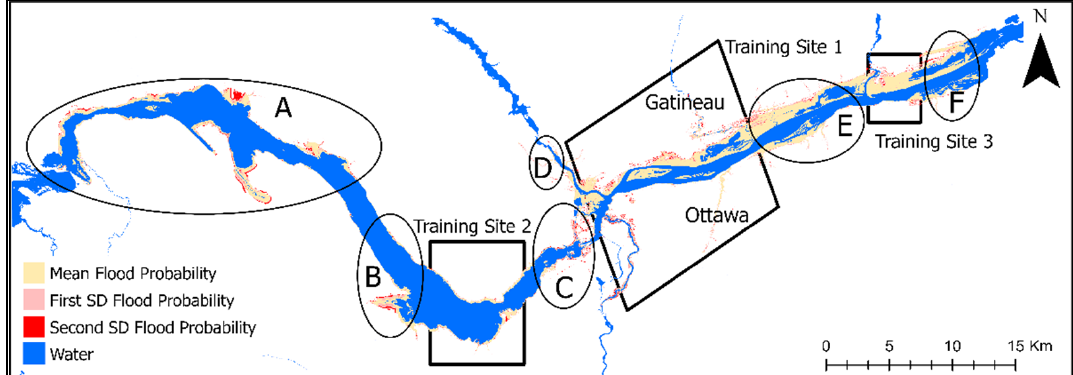
Figure 7. Final flood susceptibility map polygons generated using the flood occurrence probability thresholds of mean, first standard deviation and second standard deviation The circles ( A – F ) are indicating the locations of existing spatial gaps within the FDRP flood hazard areas, which were used to validate flood prediction accuracy against the NFHDL maps shown in Figure 8.